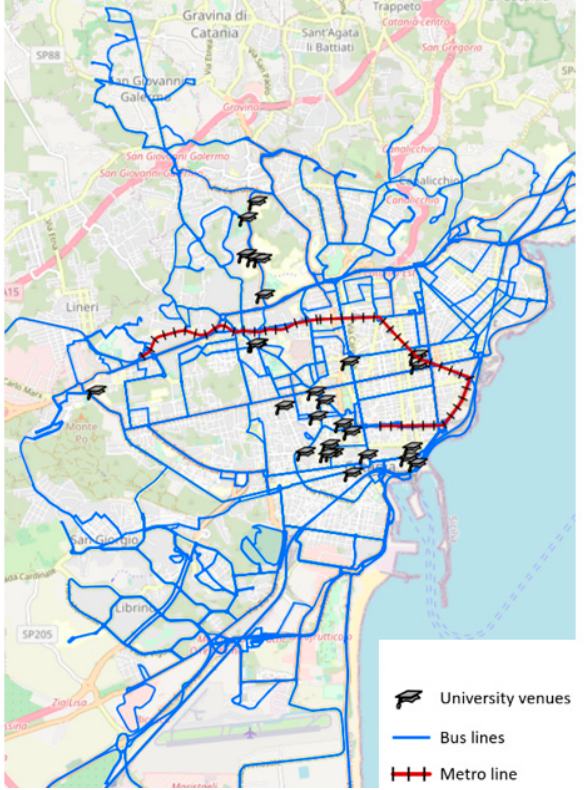
Figure 4. Public Transport (PT) network in Catania.